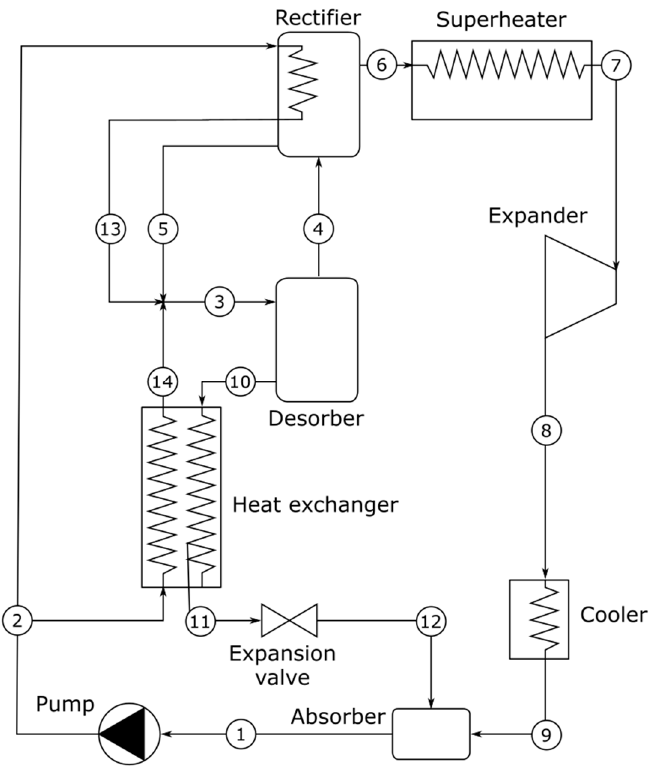
Figure 25. Equipment of a Goswami